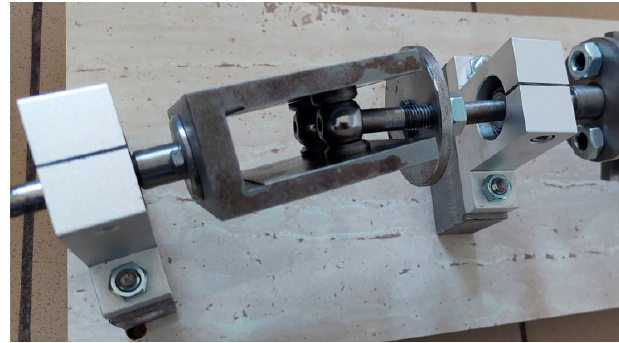
Figure 9. Constructive solution for contact stress reduction in the contact of the bipod pair: ( a ) direct contact sphere-plane; ( b ) intermediate pads for stress diminution; ( c ) assembly of the higher pair.